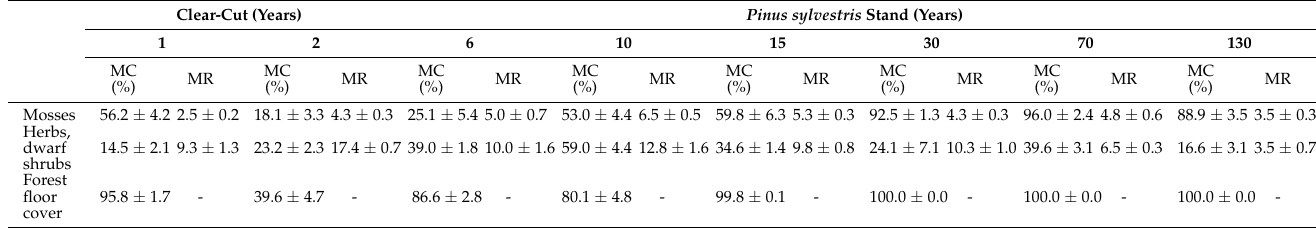
Table 2. Mean cover (MC, %) and mean richness (MR, number) of the plant species, and forest floor cover (%) at different Pinus sylvestris sites, including 1–2-year-old clear-cuts and 6–130 years old